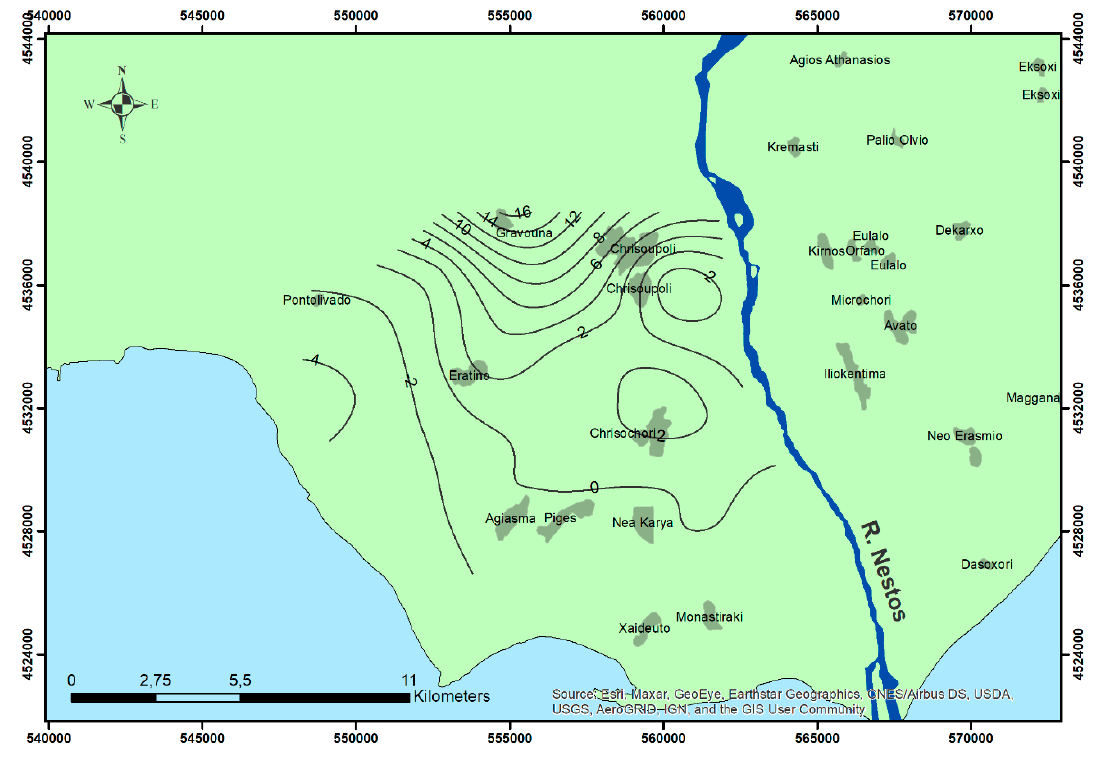
Figure 6. Piezometric map of the unconfined aquifer (October 2019).